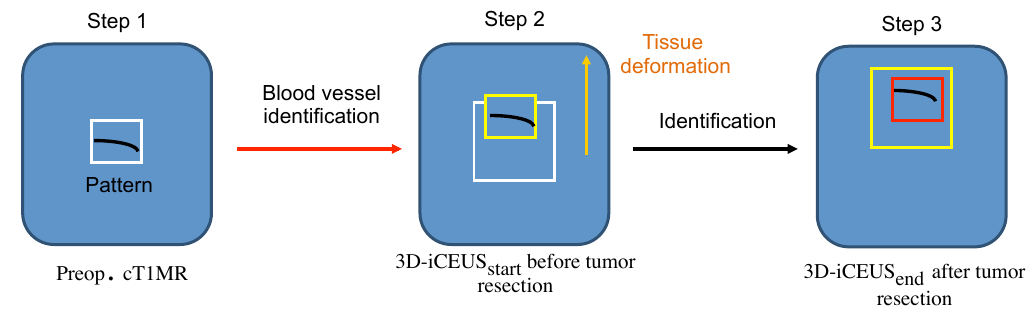
Figure 3. Process of the proposed vascular structure